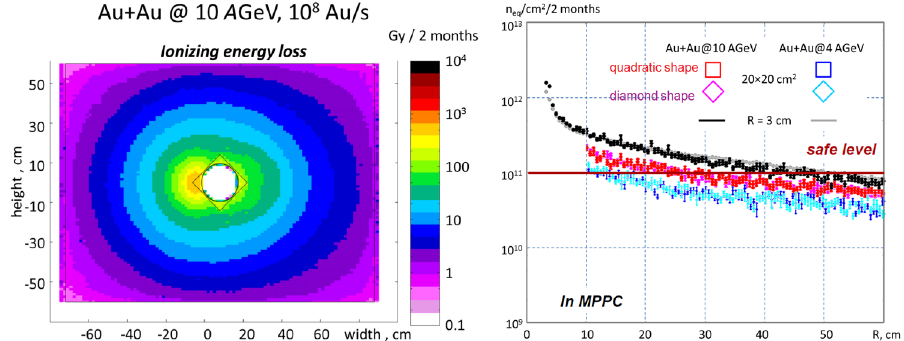
Figure 5. (Left) Distribution of ionizing energy loss in transverse plane at 20 cm depth from the PSD module front. (Right) Non-ionizing energy loss vs radius at transverse plane where MPPCs are located for di ff erent configurations of the beam hole